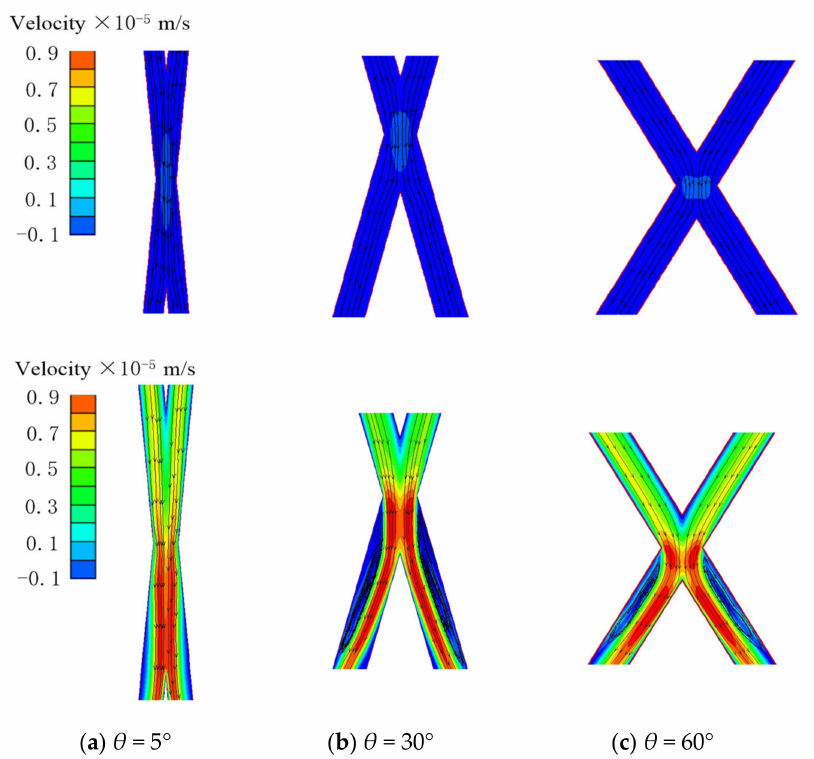
Figure 10. Flow velocity profiles for CFI at hydraulic gradient J = 0.01 (top row) and J = 0.3 (bottom row)